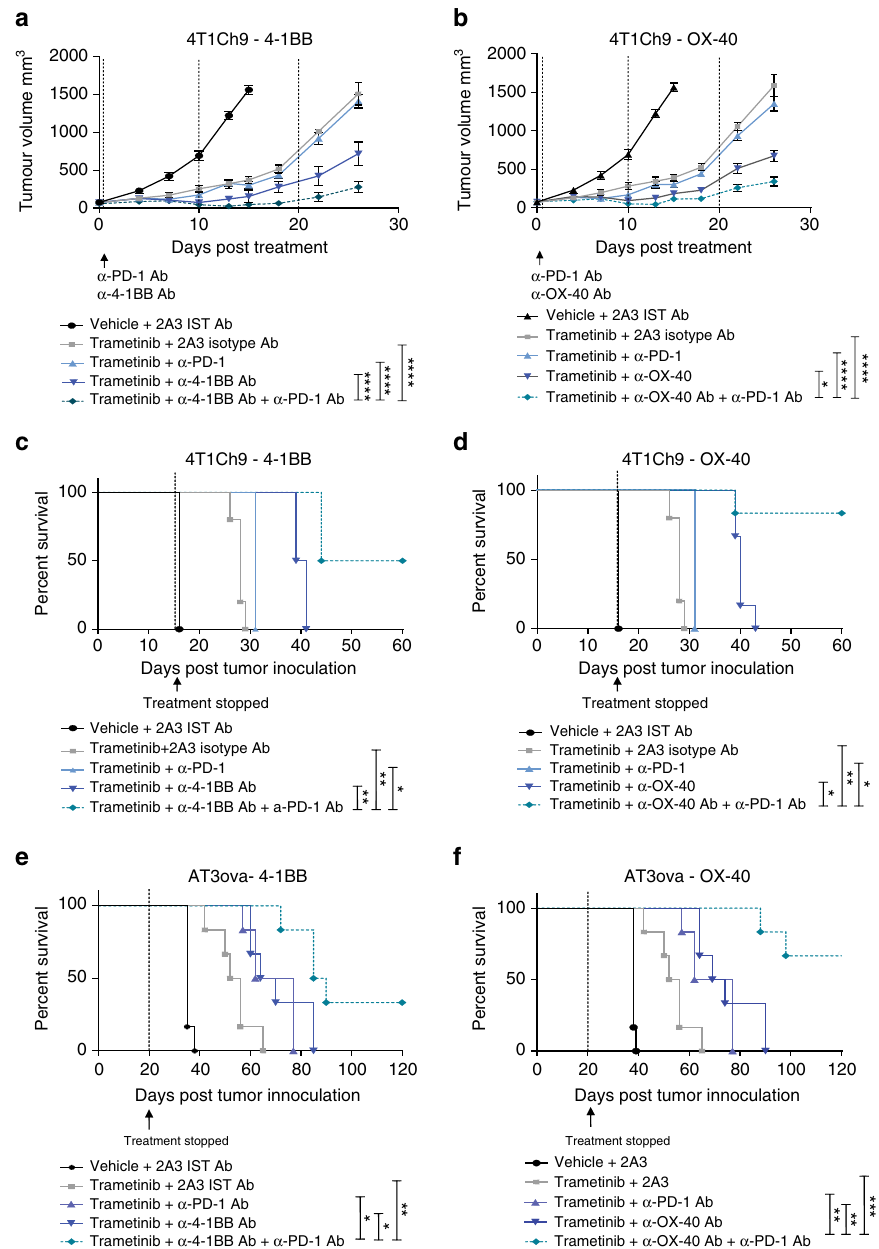
Fig. 7 Triple combination of MEK inhibition and agonist immunotherapy plus anti PD-1 checkpoint blockade leads to enhanced ef fi cacy in AT3ova and 4T1Ch9 tumor bearing mice. Mice ( n = 6 per group) bearing established 4T1Ch9 ( a – d ) or AT3ova ( e , f ) tumors were treated with a double combination of trametinib via daily oral gavage for 20 days (AT3ova) or 15 days (4T1Ch9) and either α -4-1BB, α -OX-40, or α -PD-1 antibody or triple combination of trametinib and either agonist ( α -4-1BB, α -OX-40) in combination with α -PD-1 antibody; three doses (4T1Ch9) or four doses (AT3ova) via IP injection on days 0, 4, 8, and 12 or combination of trametinib and agonists. a , b Tumor growth volume (mm 3 ) in the 4T1Ch9 model and survival ( n = 6) in the 4T1Ch9 ( c , d ) and AT3ova ( e , f ) were monitored. End point was determined as when tumors reached an ethical limit of 1400 mm 3 (mean tumor volume ± SEM). Controls groups are duplicated between panels as these experiments were performed concurrently. P -values represent two-way ANOVA, post hoc Tuckey ’ s tests for tumor growth, and log ranked (Mantel – Cox) test for survival proportions. * P < 0.05, ** P < 0.01, *** P < 0.001, **** P <